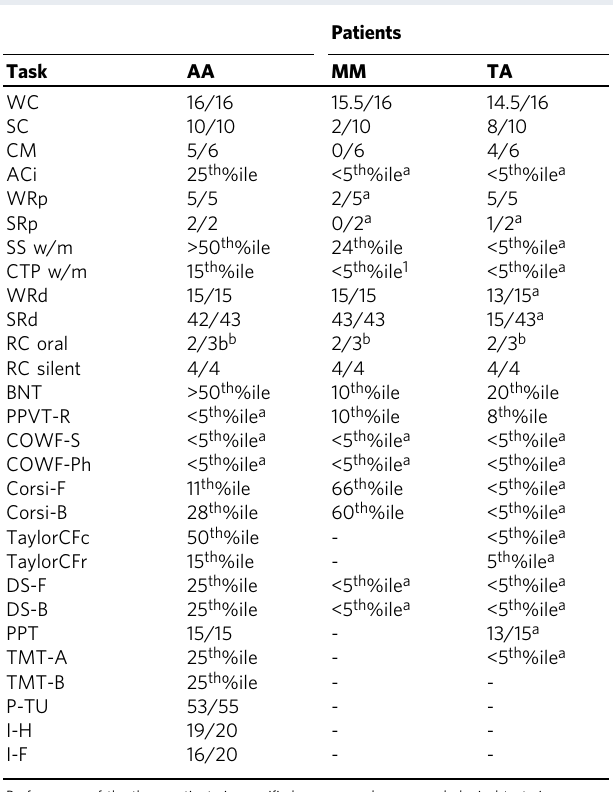
Table 2 Neuropsychological and Language performance of the three patients.